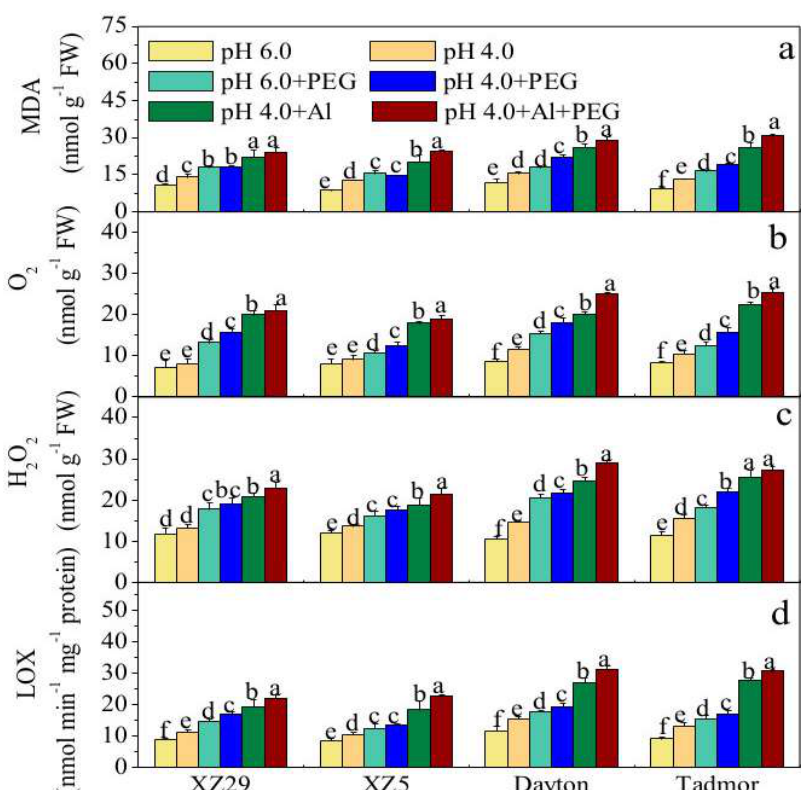
Figure 2. Effects of pH, PEG, Al, and pH 4.0+Al+PEG stresses on ( a ) H 2 O 2 , ( b ) O 2 − , ( c ) Malondialdehyde (MDA), and ( d ) Lipoxygenase (LOX) activity of four barley genotypes seven days after treatment. Error bars represent SD values ( n = 6). Different letters indicate significant differences among the treatments within each genotype according to Duncan’s multiple range test with p < 0.05.